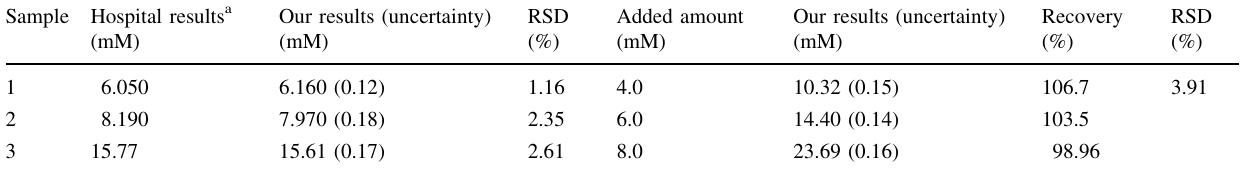
Table 2 Adding standard recovery results to determine glucose in blood serum samples Sample Hospital results a